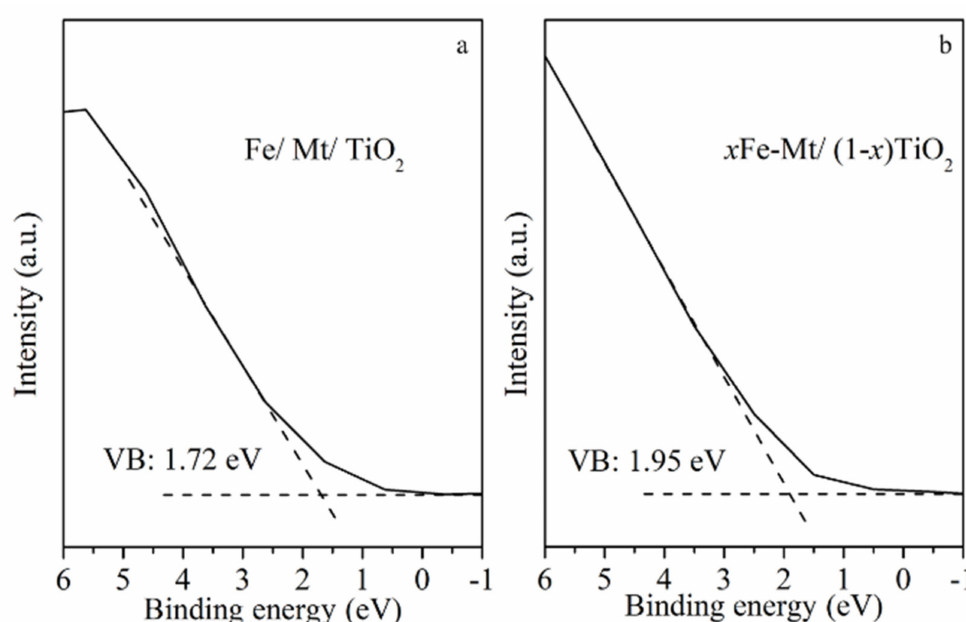
Figure 5. XPS valence band (VB) energy region of: ( a ) Fe/Mt/TiO 2 ; ( b ) x Fe-Mt/(1 − x )Fe-TiO 2